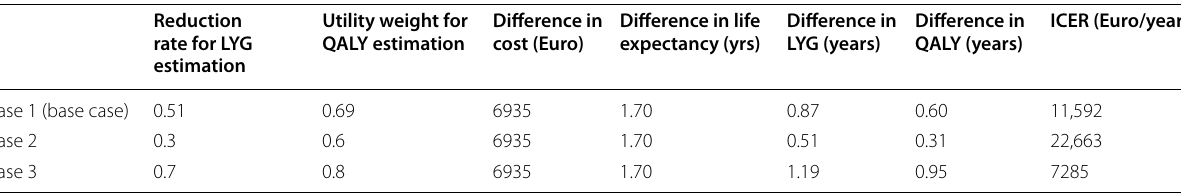
Table 4 Sensitivity